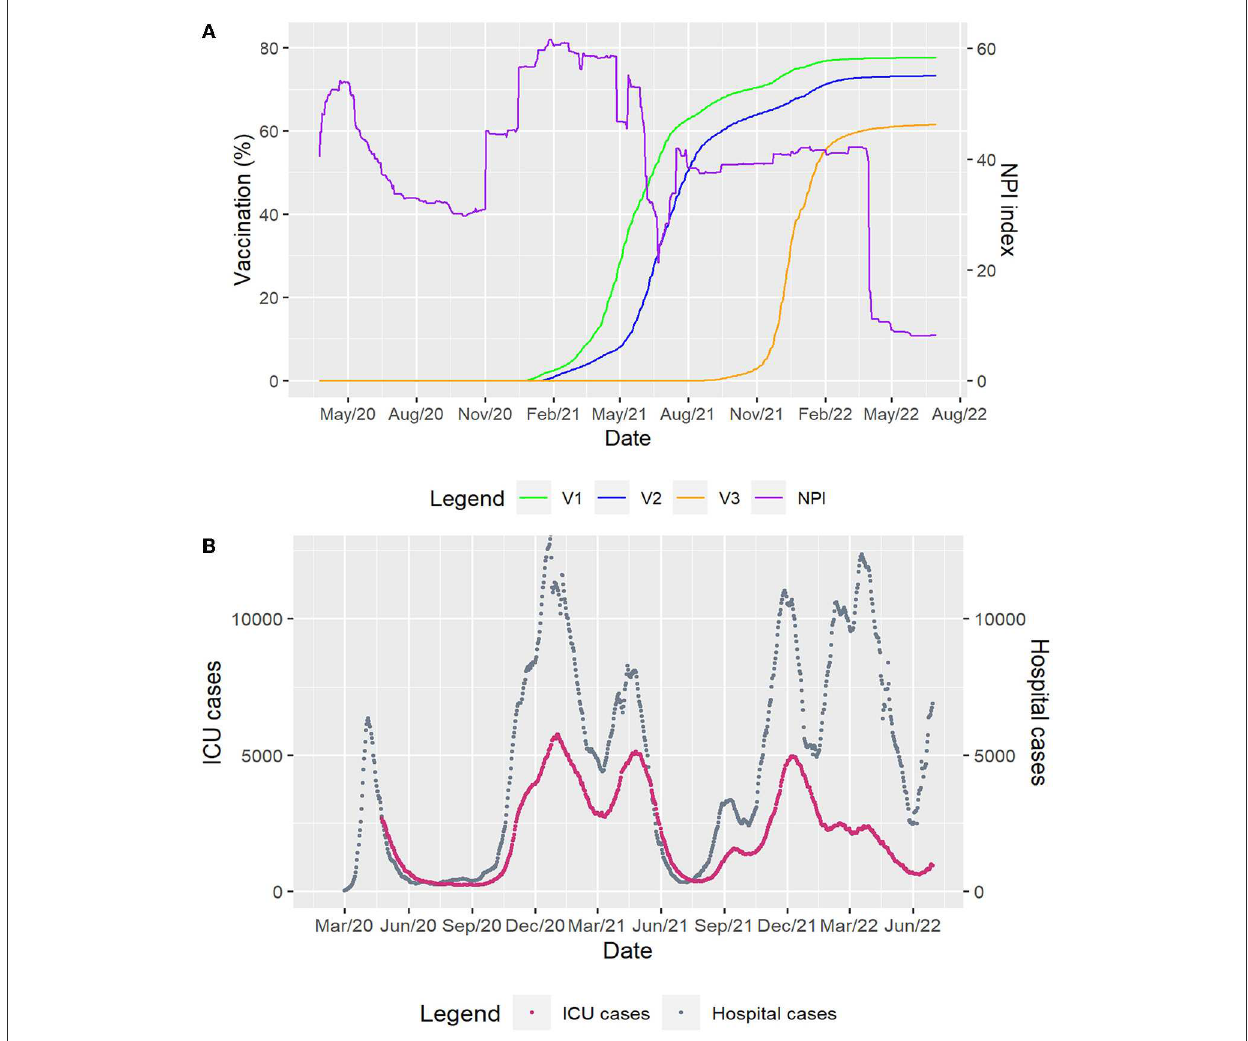
FIGURE1 Time series of German data considered. (A) The predictors represented by the daily cumulative proportions of people vaccinated with one dose ( V 1 ), two doses ( V 2 ), three doses ( V 3 ) and the non-pharmaceutical interventions ( NPI ) index. (B) The outcomes: the daily numbers of prevalent hospital patients (hospital cases) and intensive care unit patients (ICU